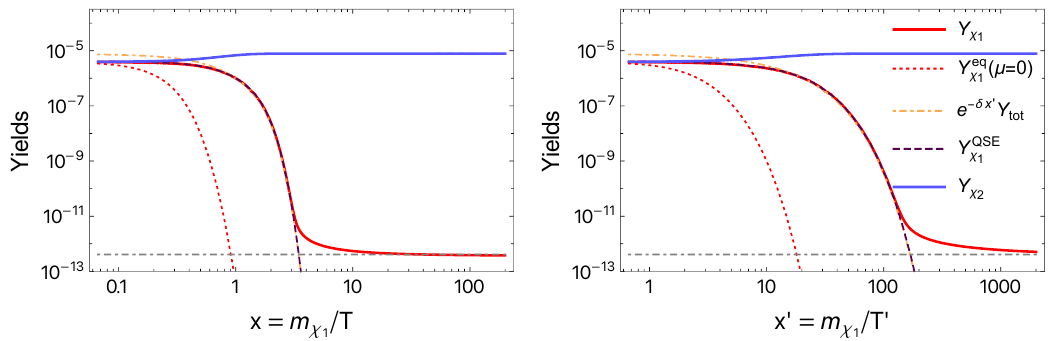
Figure 2 . The abundance evolution for the near-degenerate case with m χ = 1 TeV and δ = 0 . 1 as 1 a function of x (left panel) and x 0 (right panel); we assume ξ i = 0 . 1 , and g 1 g 2 /m 2 = 1 / (4 TeV ) 2 . A The red (blue) solid lines show the evolution of Y χ ( Y χ ), and the dotted red lines show the 1 2 equilibrium value of Y χ calculated from T 0 with zero chemical potential. The orange dot-dashed 1 lines show e − δx 0 Y tot = e − ( m χ 1 − m χ 2 ) /T 0 ( Y χ + Y χ ) , which is an approximation of the exact quasi- 1 ,i 2 ,i static equilibrium solution, Y QSE (purple dashed lines); see eq. (A.4) for more details. Both show χ 1 χ 1 . The observed DM abundance is shown as gray dot-dashed